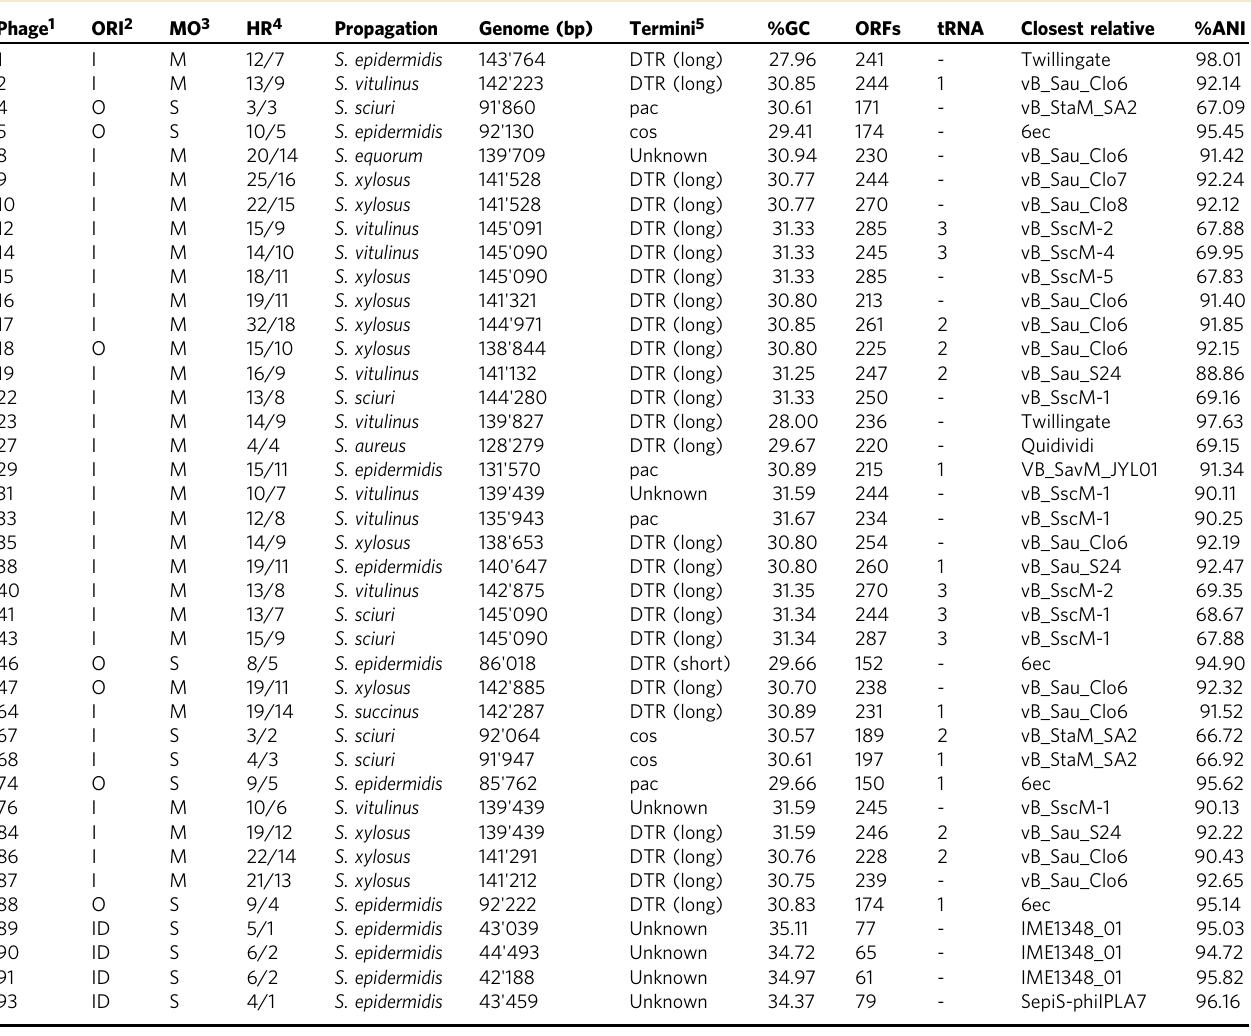
Table 3 Characteristics of the 40 sequenced staphylococcal phage